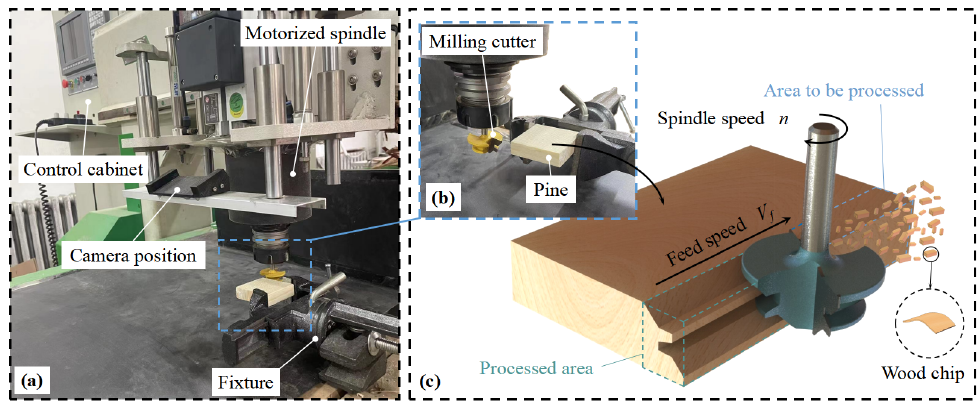
Figure 1. Wood circumferential milling and wood chip diffusion state. ( a ) Pine specimen clamped on the machine. ( b ) Milling cutter fixed on the electric spindle and pine specimen fixed on the fixture. ( c ) Schematic diagram depicting the chip generation process.